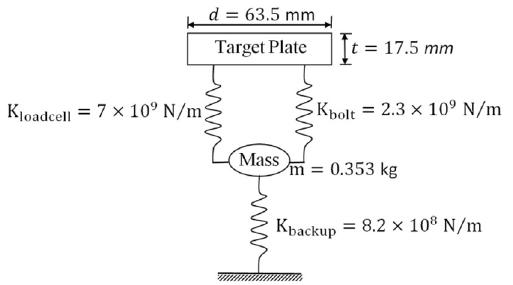
Figure 4. Schematic representation of the steel cylinder (load cell) and supporting springs.